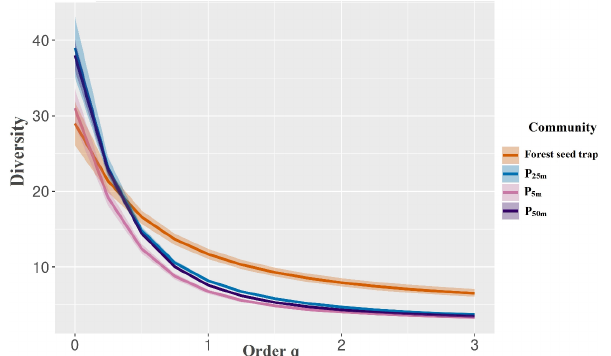
Figure 5. Diversity profile of perches at 5, 25, and 50m from the edge of the forest fragment and forest seed traps sampled at the Cascata Experimental Station, southern